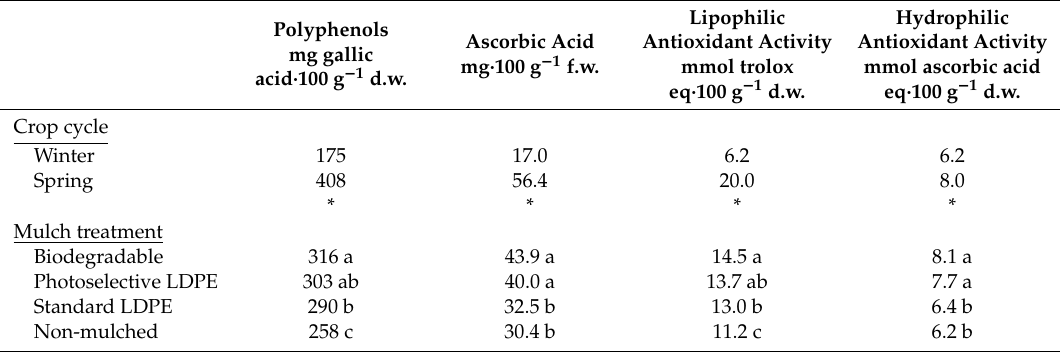
Table 5. Mean values of antioxidant content and activity of perennial wall rocket leaves as a ff ected by crop cycle and mulch